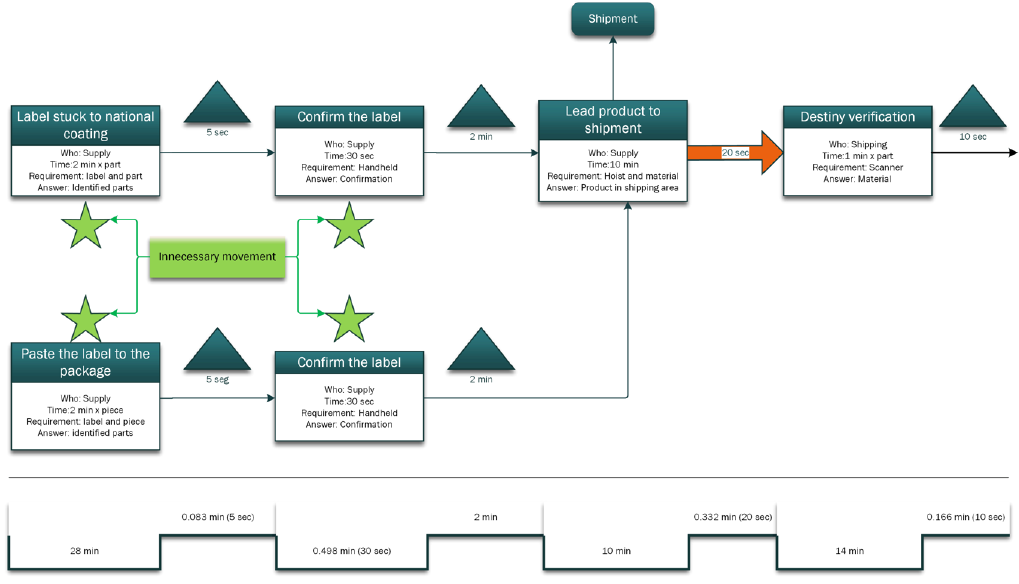
Figure 13. The fourth part of seven of the Current State Value Stream Map with wastes.